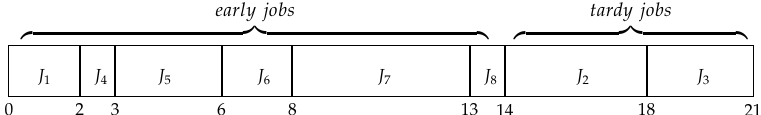
Figure 1. Schedule σ 1 corresponding to Instance I 1 .